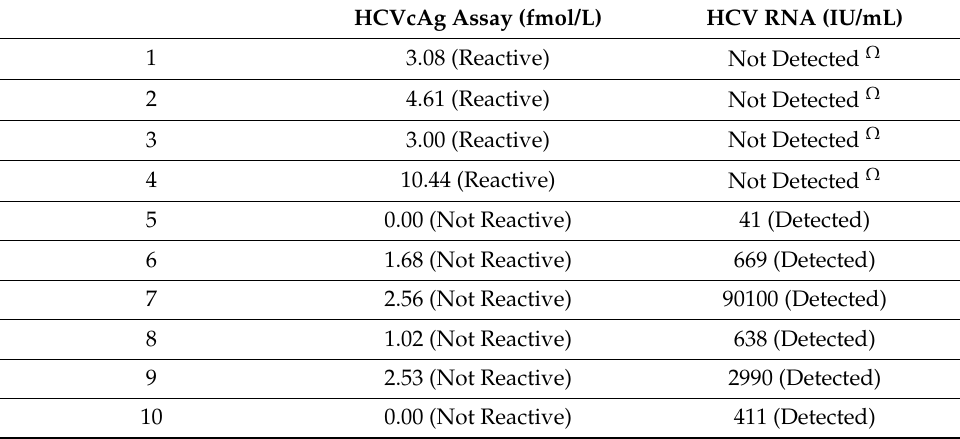
Table 1. Discordant results between of HCVcAg assay ( ≥ 3 fmol/L) and HCV RNA ( ≥ 12 IU/mL)